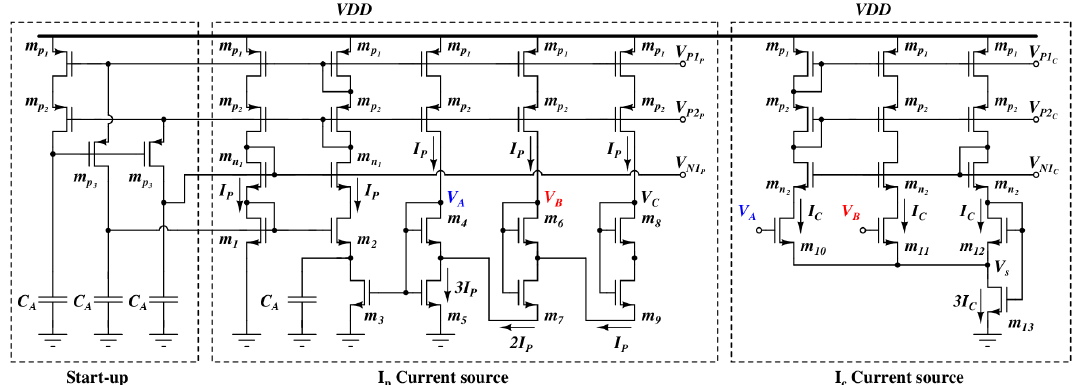
Figure 6. Proposed current source